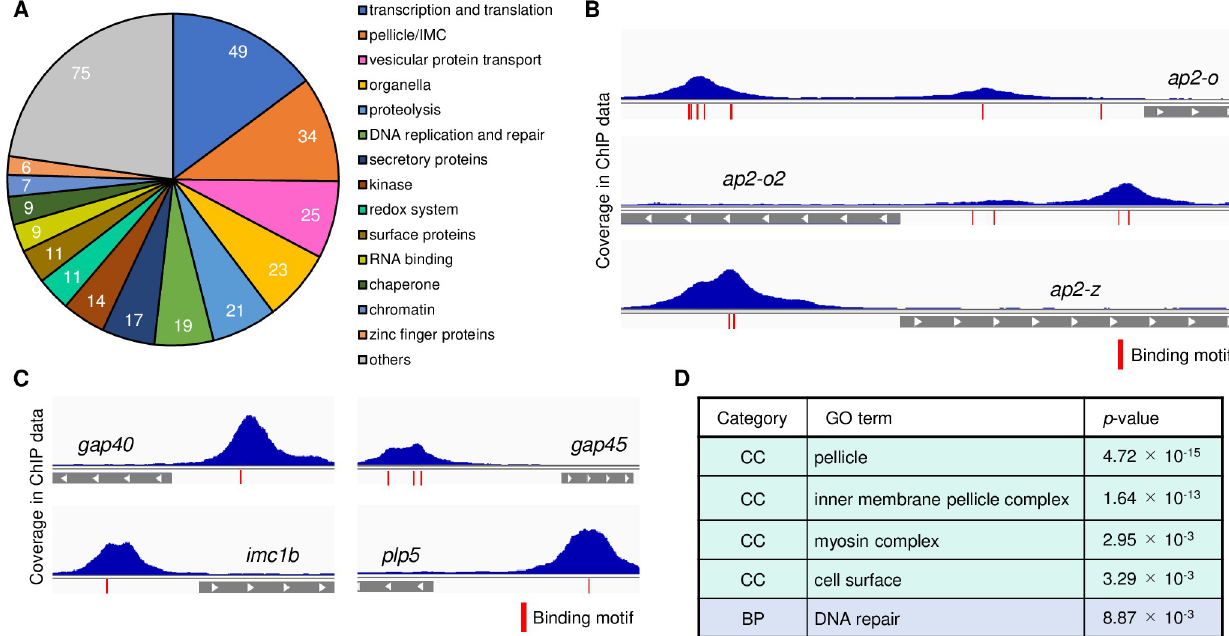
Fig 5. Target analysis of AP2-Z using ChIP-seq data. (A) Classification of the target genes of AP2-Z into 14 functional groups according to their product description annotated on PlasmoDB. (B) Transcription factor genes in the targets of AP2-Z. Histograms show sequence coverage of the ChIP sample in experiment 1. Gray bars indicate a partial open reading frame. Positions of the AP2-Z binding motifs are indicated in red. (C) Representative peak images of target genes essential for ookinete development. (D) GO analysis showing enrichment of genes with specific functions in the targets of AP2-Z. Terms with p -value < 0.01 were shown. CC = Cellular Components, BP = Biological